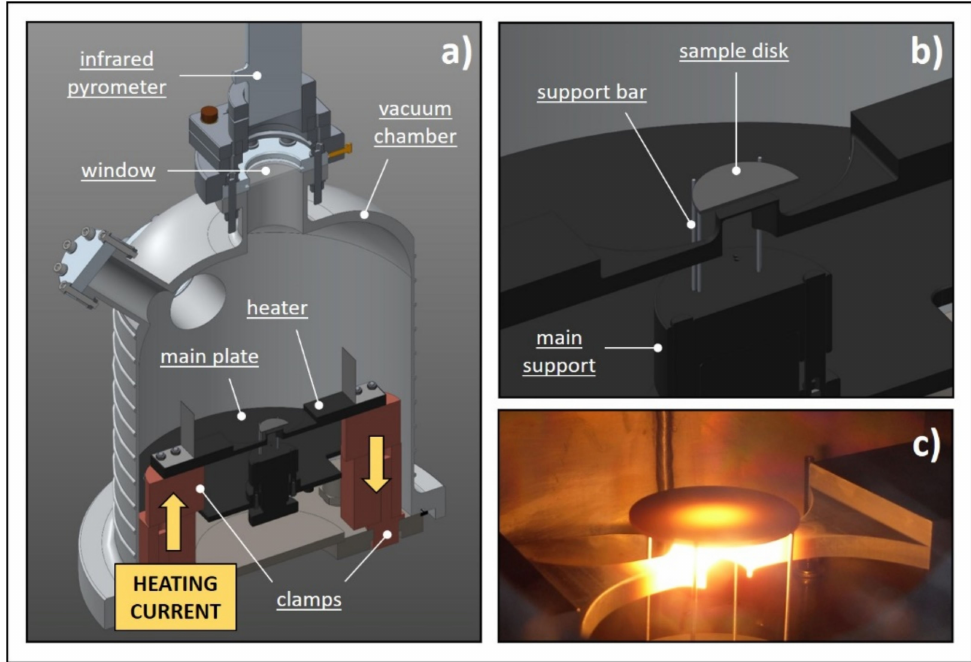
Figure 4. The experimental apparatus adopted for both emissivity and thermal conductivity esti- mations; ( a ) general CAD view of the whole apparatus; ( b ) detailed CAD view of the sample area; ( c ) picture of the sample area at high